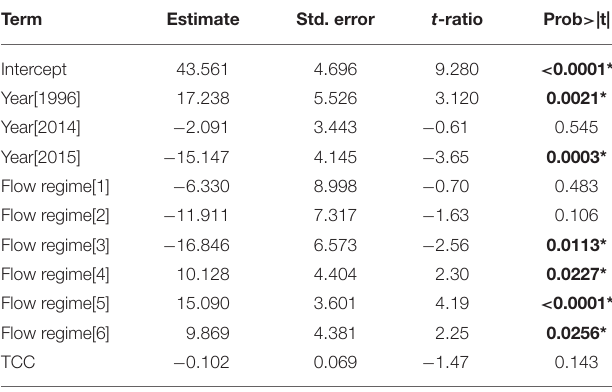
TABLE 2 | Model output (GLMM) of bleaching prevalence (% live coral cover) (October surveys only) by year (i.e., 1996, 2014, 2015), flow regimes (i.e., 1–6), and total coral cover (TCC).